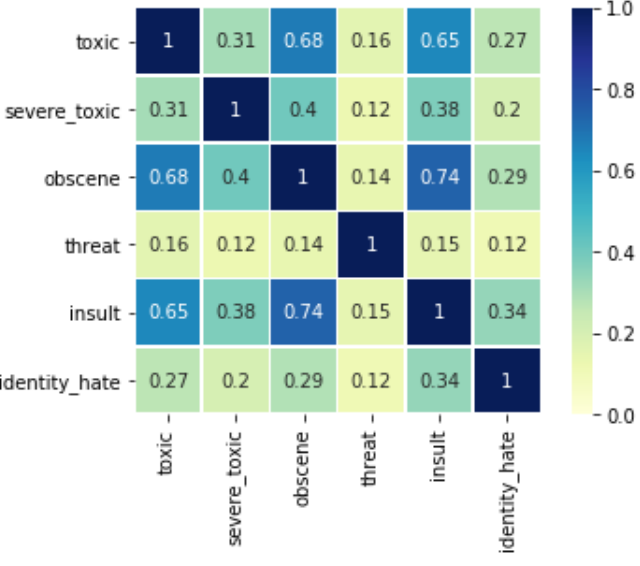
Figure 6. Correlation of features and